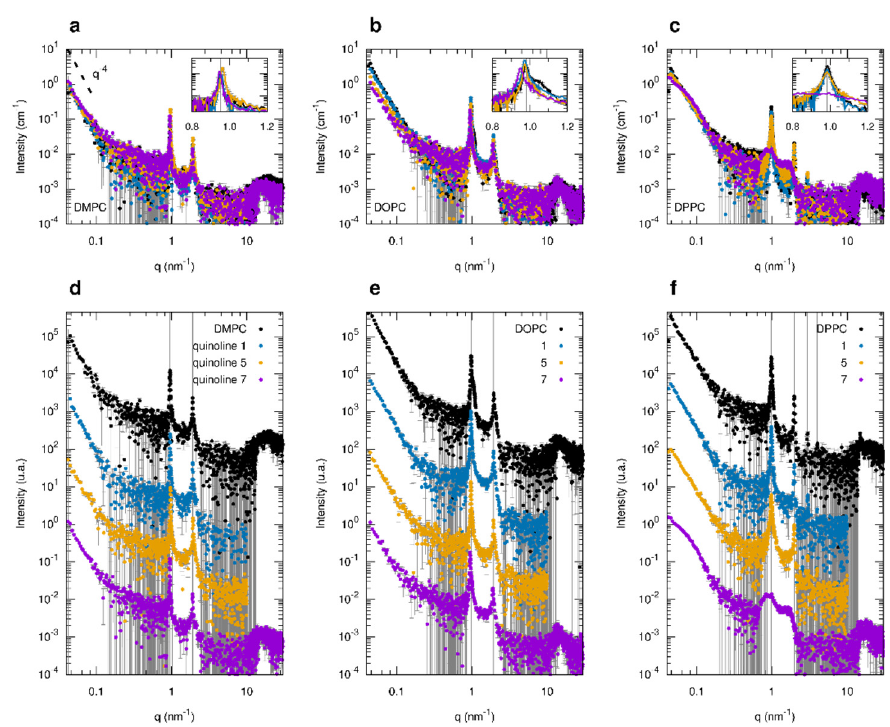
Figure 7. SAXS curves of free (black circles) and some quinoline-loaded phospholipid containing multilamellar vesicles (MLV; blue, orange, and purple circles for quinoline 1 , 3 , 5 , respectively). In panels ( a – c ), the data for MLV containing DMPC, DOPC, and DPPC are shown, respectively, with intensity in absolute units. The insets highlight the first diffraction peak. In ( d – f ), the same curves have been shifted on the intensity axis by a suitable factor to avoid data overlap and help visualization.